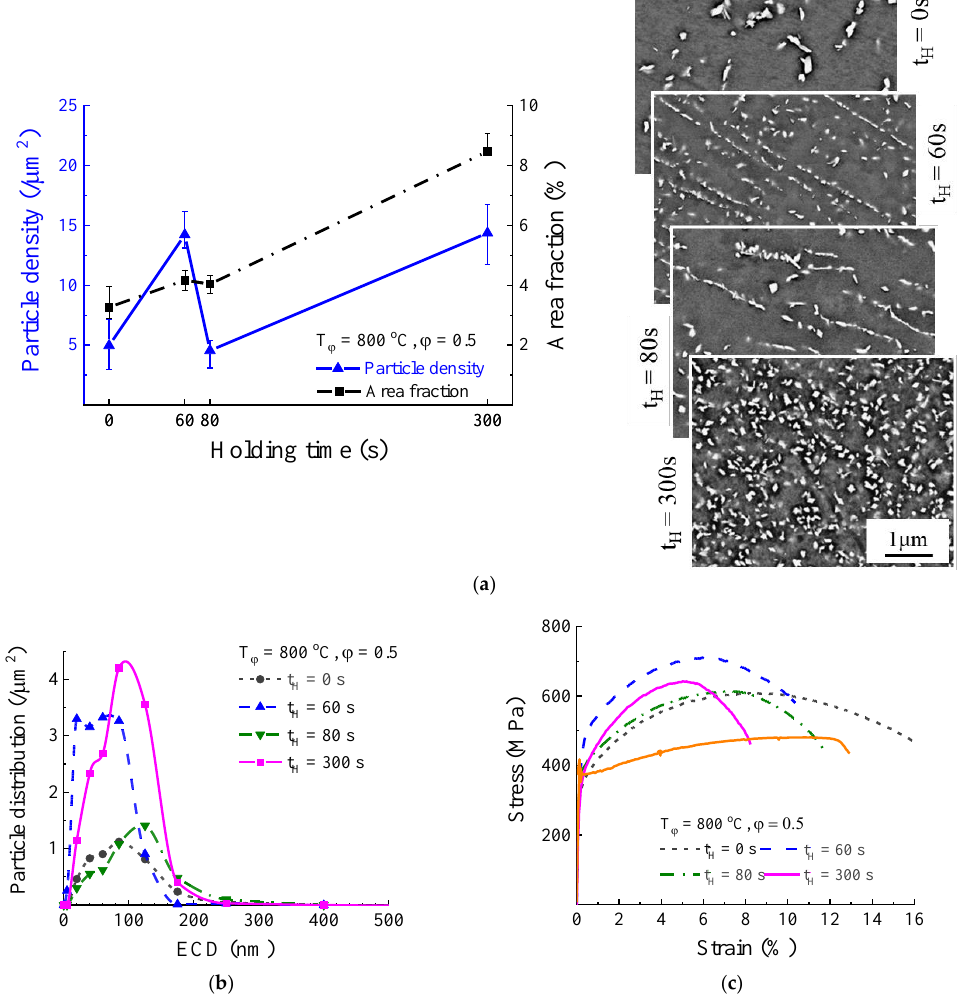
Figure 9. Impact of holding time on ( a ) particle density and area fraction, ( b ) particle size distribution, and ( c ) tensile properties (T = 800 °C, φ = 0.5, t H = 0, 60, 80, 300 s).